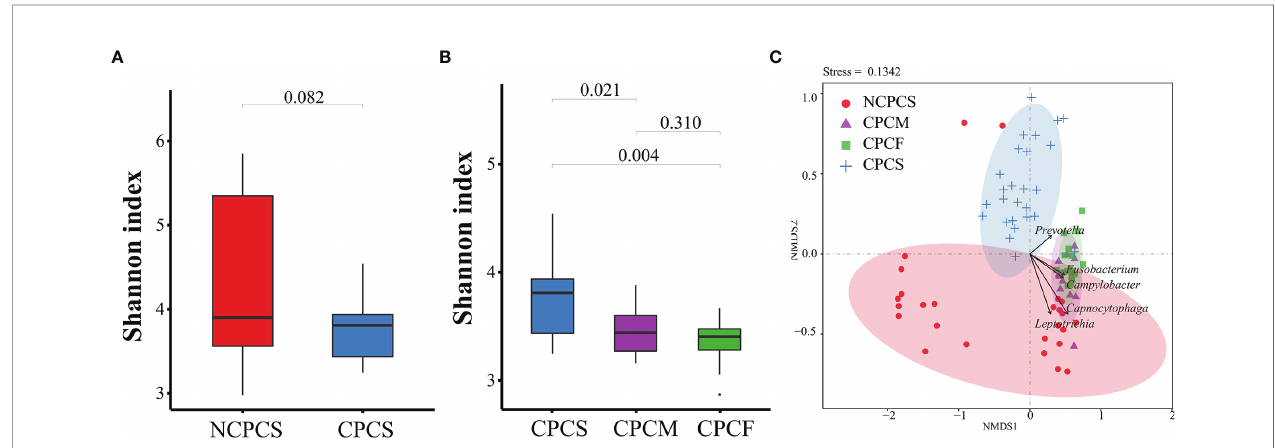
FIGURE 2 | Bacterial diversity of subgingival plaque microbiota and NMDS distribution analysis. (A) The Shannon index detection between NCPCS and CPCS. (B) The Shannon index among CPCS, CPCM, and CPCF. (C) NMDS analysis of the SPM samples from NCPCS, CPCM and CPCF, and CPCS. NCPCS, non-CP children with severe or extremely severe caries; CPCS, CP children with severe or extremely severe caries; CPCM, CP children with mild-to-moderate caries; CPCF, CP children without caries.